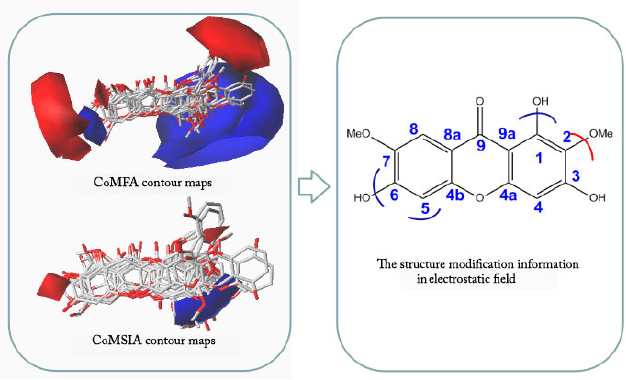
Figure 6. Steric field views of 14 xanthones.